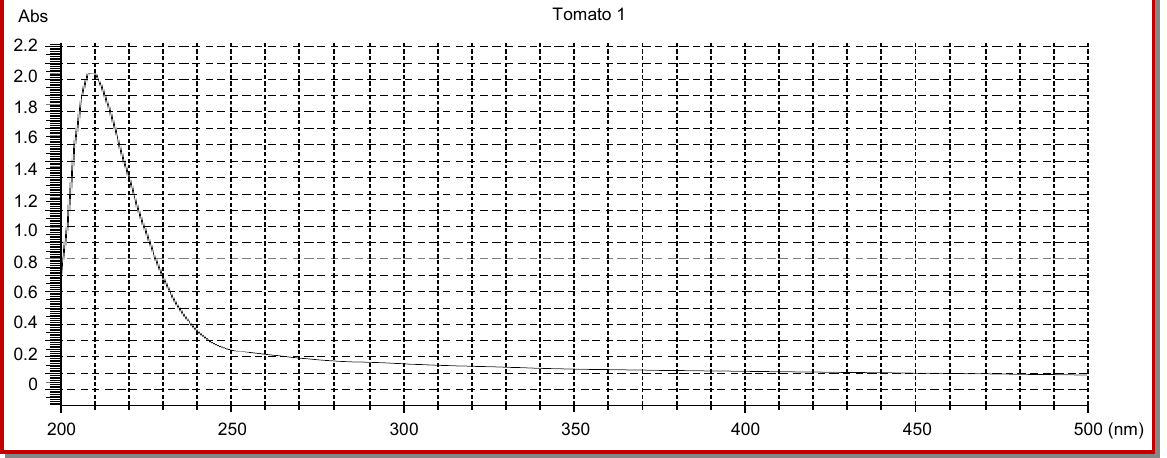
Figure 2: Peak observed at 210 nm for the sample (aqueous extract of Solanum lycopersicum